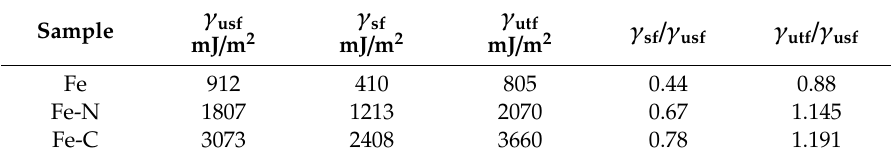
Table A1. Values of γ sf , γ usf , and γ utf corresponding to Fe, Fe-N, and Fe-C with N or C about 4% of all